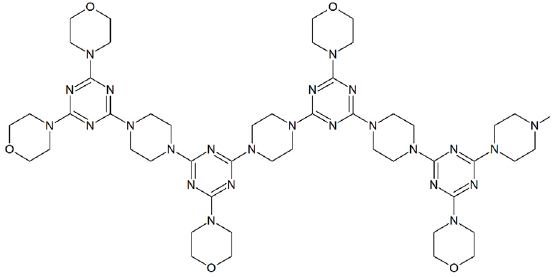
Figure 1. Chemical formula of melamine triazine.